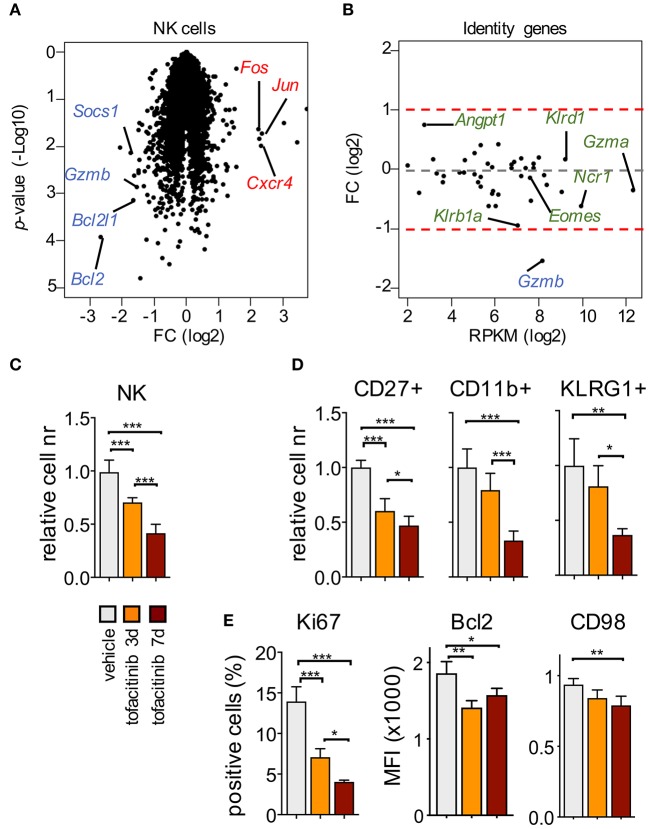
Impact of tofacitinib on the transcriptome and phenotype of splenic NK cells. (A) Volcano plot for genes expressed by splenic NK cells isolated from mice treated or not for 1 week with tofacitinib. Representative down-regulated (blue) and up-regulated (red) genes are highlighted. Two mice for treated and three for vehicle were pooled together for each replicate. (B) MA plot shows transcript abundance (x axis, mean RPKM in NK cells receiving vehicle) and FC (y axis, log2 of tofacitinib ÷ vehicle) for genes associated with NK cell identity. (C) Relative cell number for splenic NKp46+ and (D) NK cell subsets, defined by CD27, CD11b, or KLRG1 expression, at 3 and 7 days of tofacitinib treatment are shown. (E) Expression levels evaluated by flow cytometry for Ki67 (percentage of positive cells), Bcl2 [Mean Fluorescence Intensity (MFI)], and CD98 (MFI) in NK cells at 3 and 7 days of tofacitinib treatment are shown. (C–E) Statistics were performed using one-way ANOVA. Two independent experiments were combined (vehicle n = 8; 3-days treatment n = 5; 7-days treatment n = 6), and values were normalized to the mean of vehicle-treated mice for each corresponding experiment. *P < 0.05; **P < 0.01; ***P < 0.001.